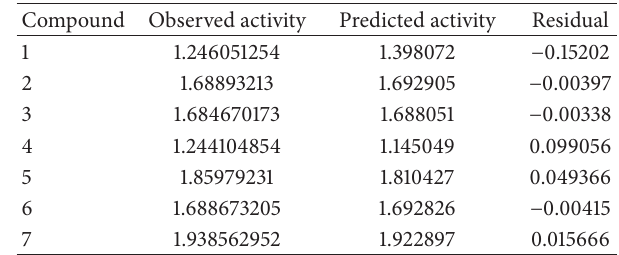
Table 4: Assessment of structural similarity of synthesized benza- mide substituted Mannich bases with standard drugs.